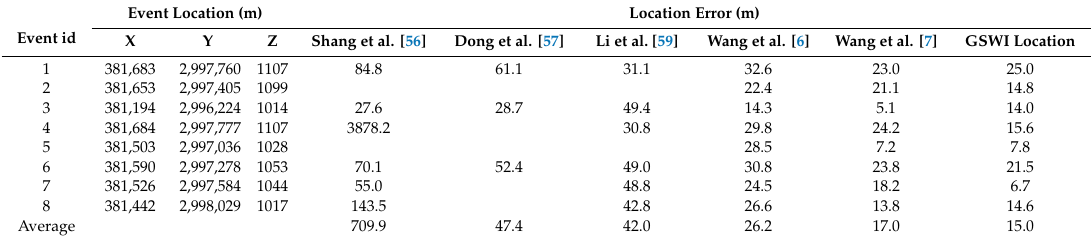
Table 1. Location errors of the eight premeasured blasting events using di ff erent location methods. Event